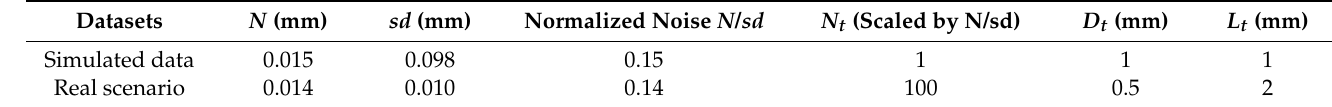
Table 5. Calculated and user input parameters for Case Study